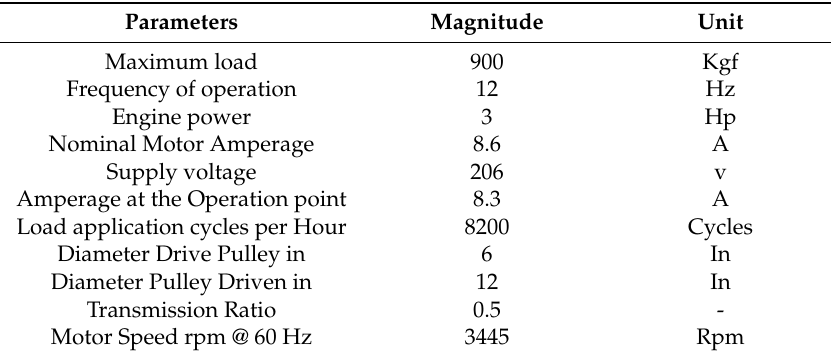
Table 3. Parameters of the